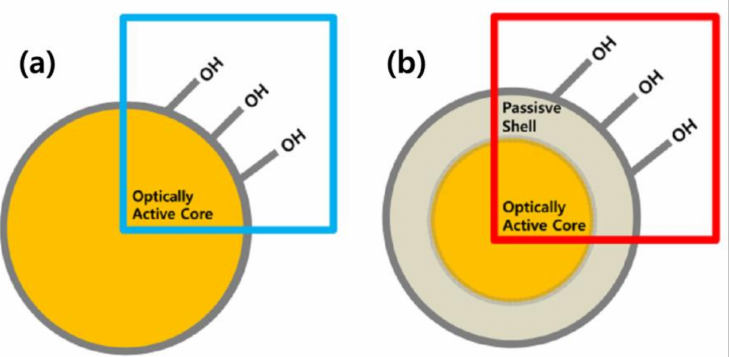
Figure 1. Schematic diagram of the structure of RE-doped ( a ) active core and ( b ) active core@passive